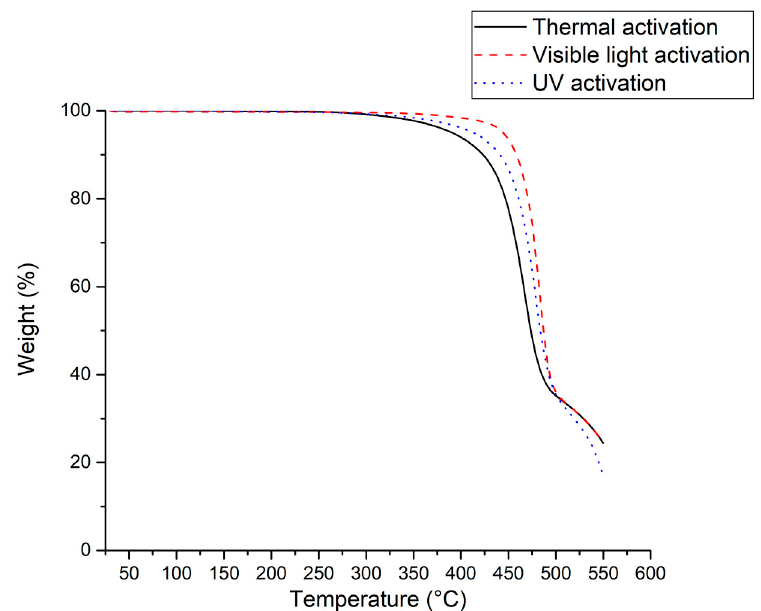
Figure 5. TGA thermograms in the air of PVDFs obtained by polymerization of VDF in the presence of [Mn(CF 3 )(CO) 5 ] after a 24 h-reaction and initiated thermally (full line), by visible (dashed line) or UV (dotted line) light.